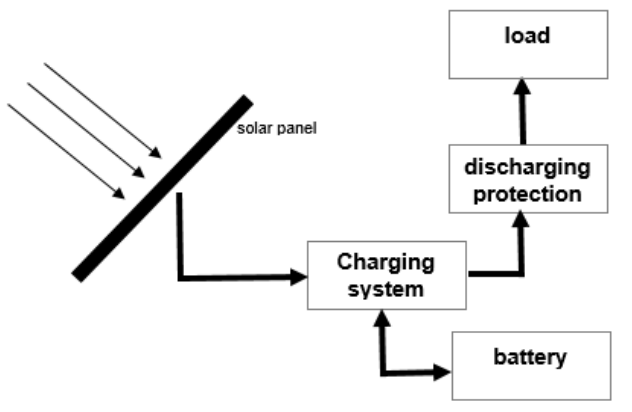
Figure 2 Illustration of a Wireless Sensor Network